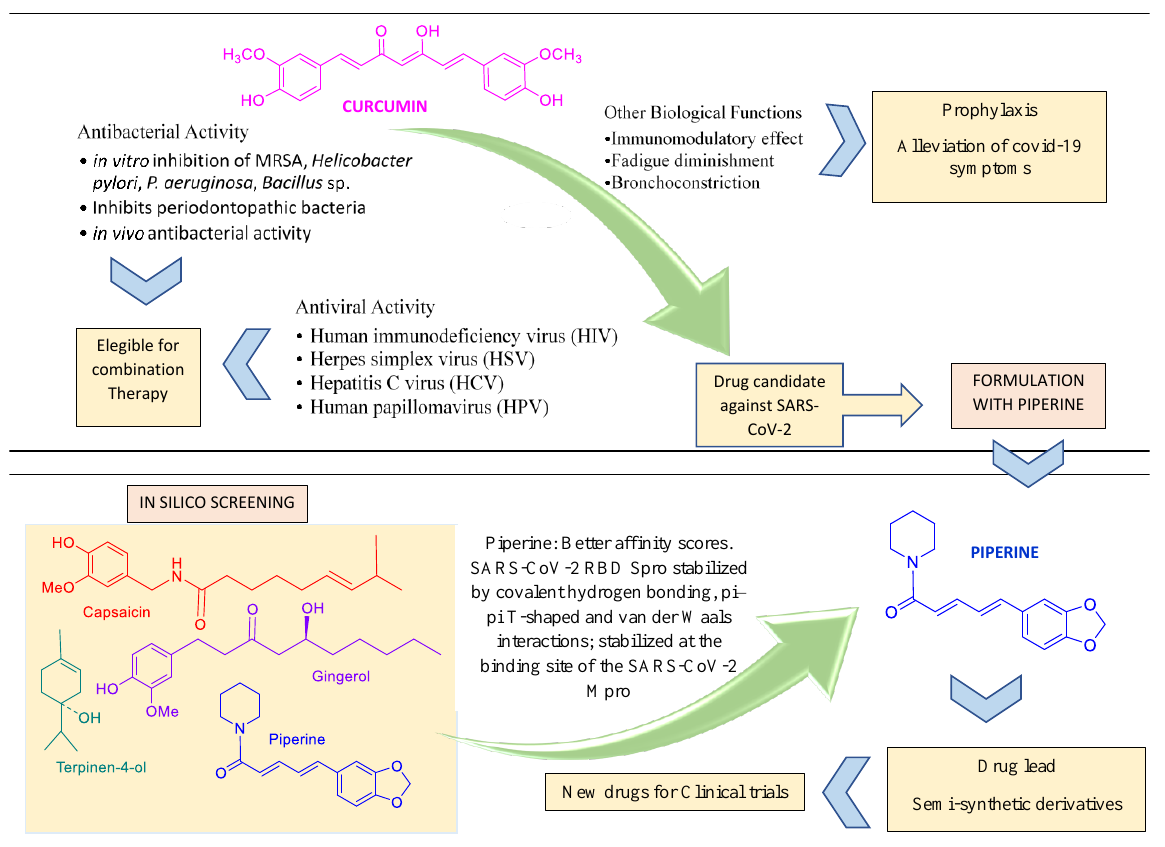
ment of nano formulations and supplements [87 – 94].